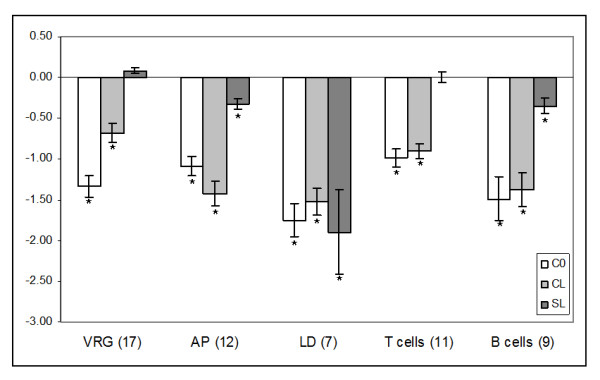
Expression changes of immune genes (microarray results). VRG - virus responsive genes, AP - antigen presentation, LD - lymphocyte differentiation. Data are mean log2-ER ± SE, numbers of genes are in parentheses.